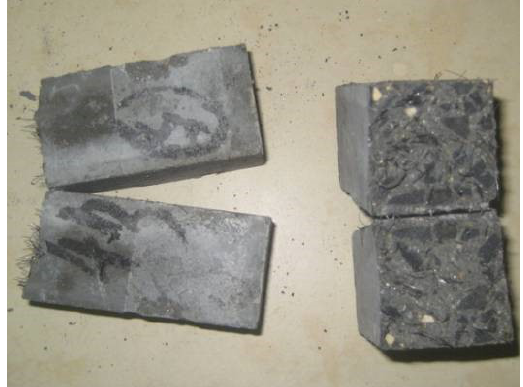
Figure 4: Fracture of the